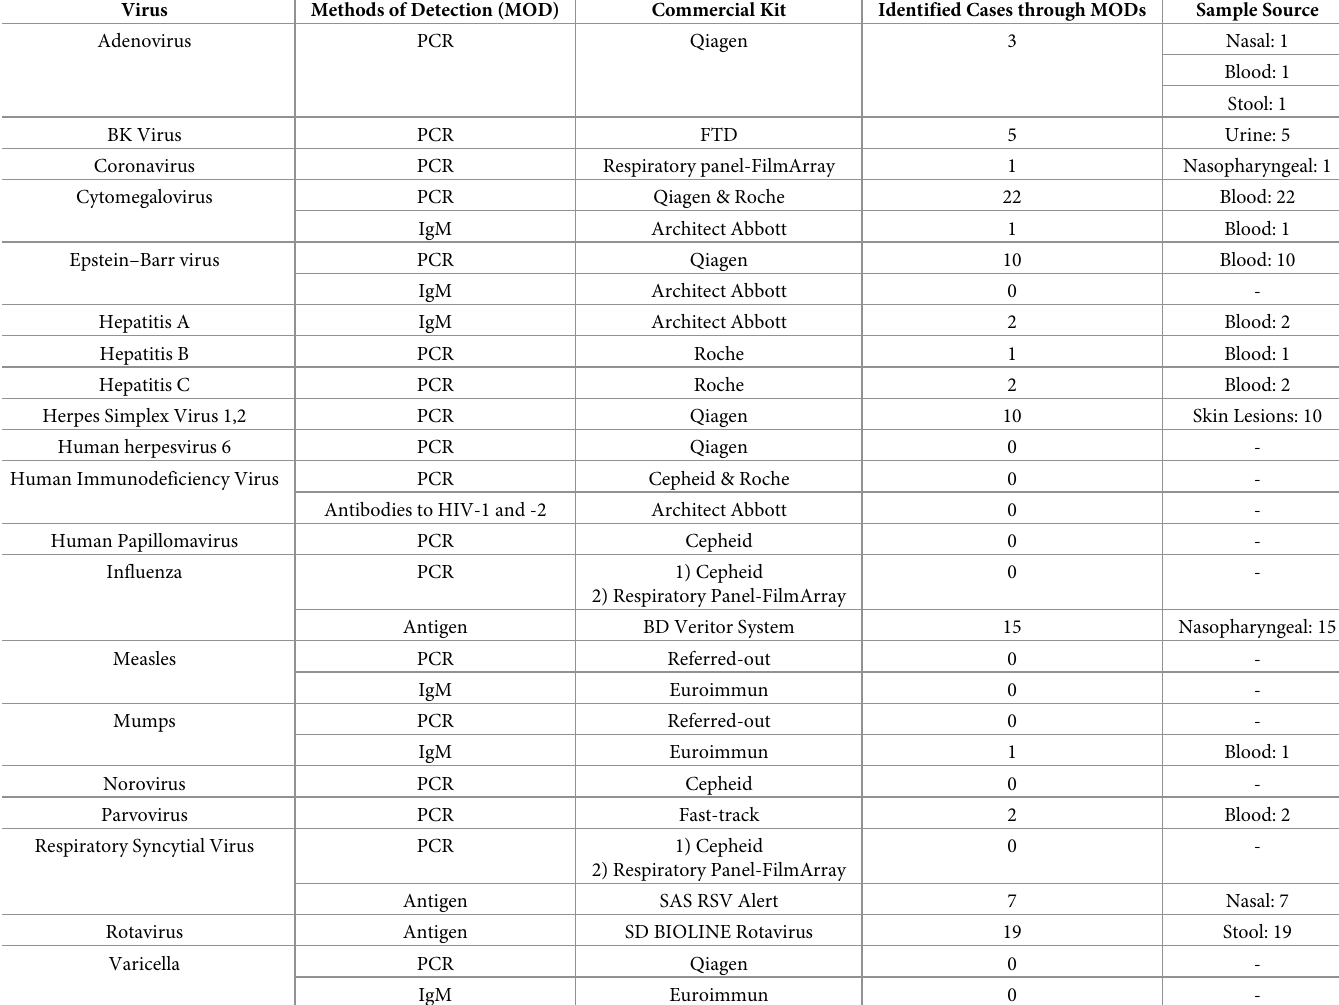
Table 1. Commonly encountered viruses in children and adolescents with cancer, with corresponding detection